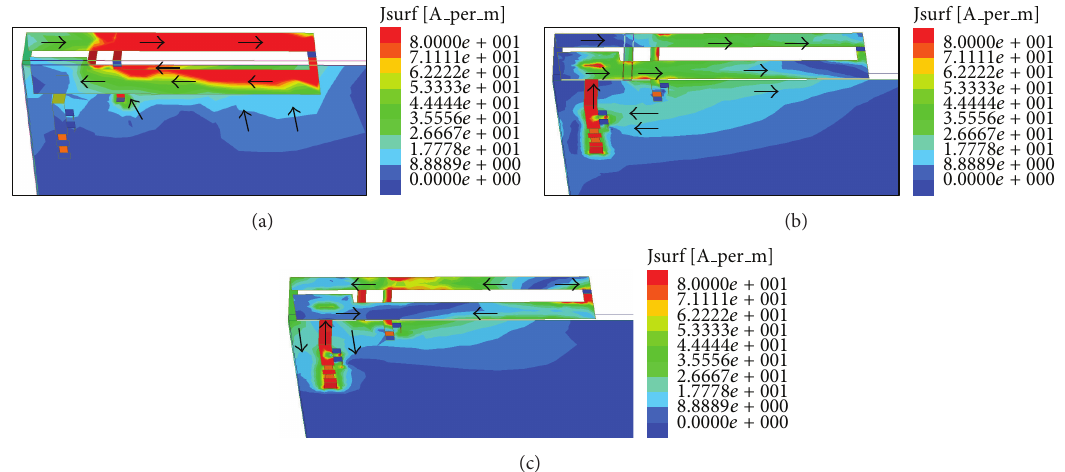
Figure 2: Simulated current distributions at different frequencies: (a) 925 MHz, (b) 1800 MHz, and (c) 2750 MHz.